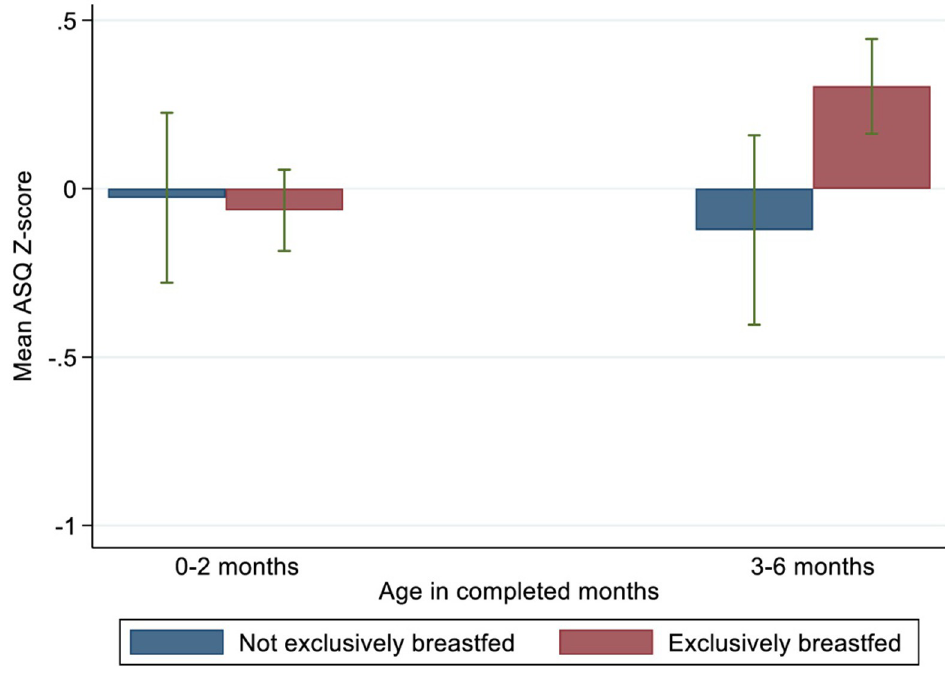
Fig 2. Children’s mean ASQ Z–scores and age groups in months by EBF group.